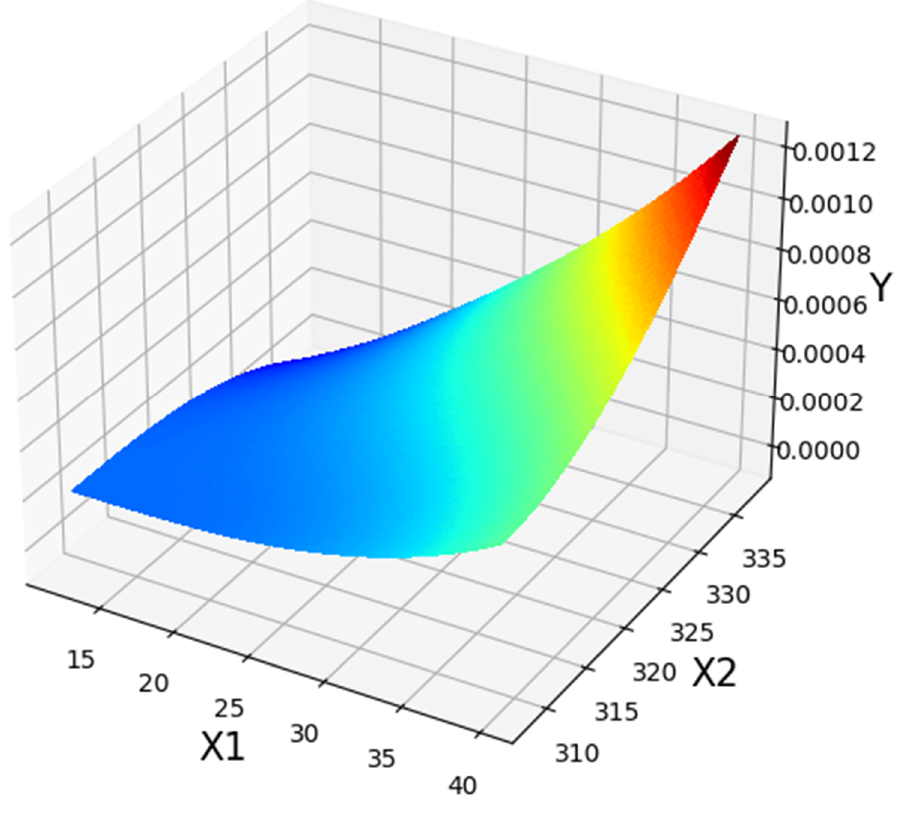
Figure 4. 3D shows initial and result amounts (NuSVR Model).